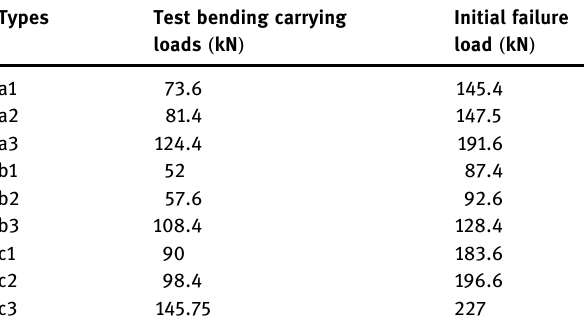
Table 3: Test results